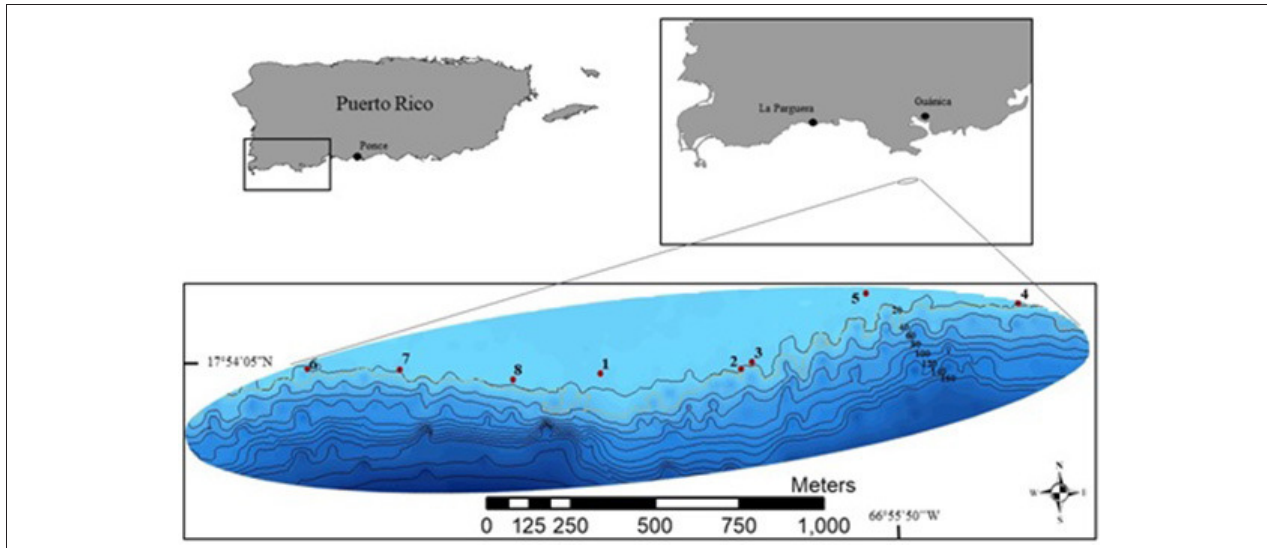
FIGURE 1 | Site map for the central portion of the Guánica shelf edge, Puerto Rico. Numbers one to eight represent each specific transect area for the shallow (20m) surveys, with the mesophotic (45m) surveys being done directly adjacent to the shallow surveys.